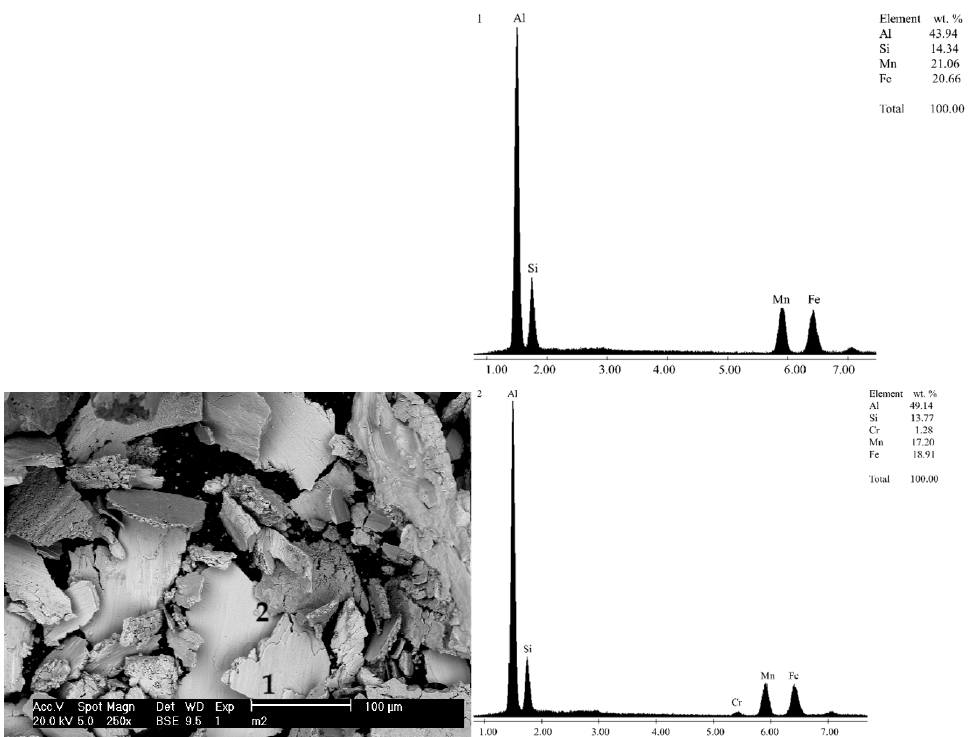
Figure 17. SEM image of an area of the coating of a sample processed at 850 °C and 20 MPa for 7200 s after pin-on-disk wear testing (load of 50 N) and EDS spectra of the indicated particles.